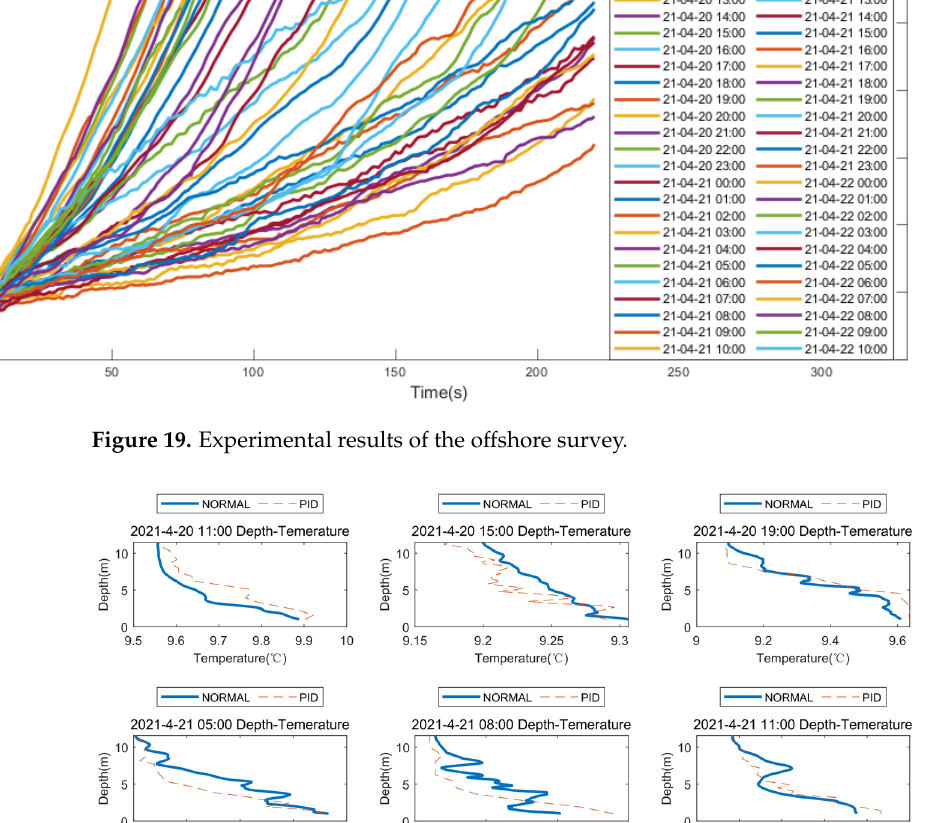
Figure 20. AUV and MANUAL depth-temperature comparison.